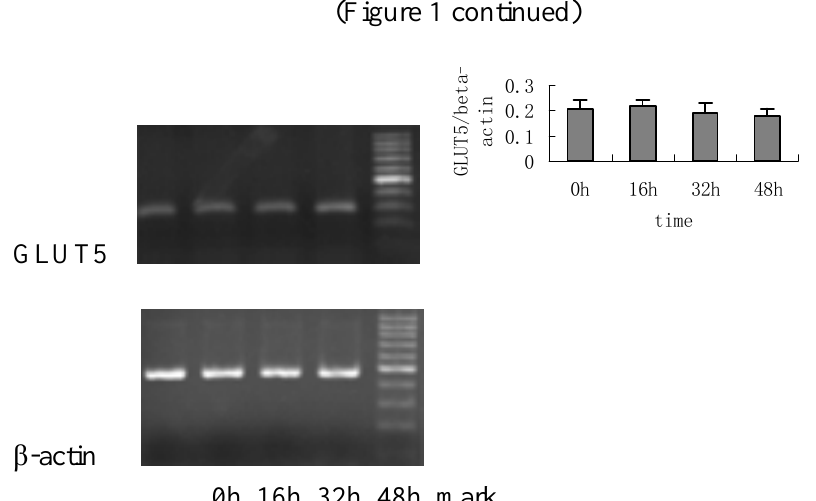
Figure 1. With the treatment of 5 mmol/L sodium butyrate in complete medium on HT-29 cell line for 16,32,48h, the expression of GLUT1 mRNA decreased obviously comparing with the cells without treatment (p*<0.05), but there was no significant change of GLUT2, GLUT3, GLUT5, MCT1mRNA, and GLUT4 was not detected in HT-29 cell line.